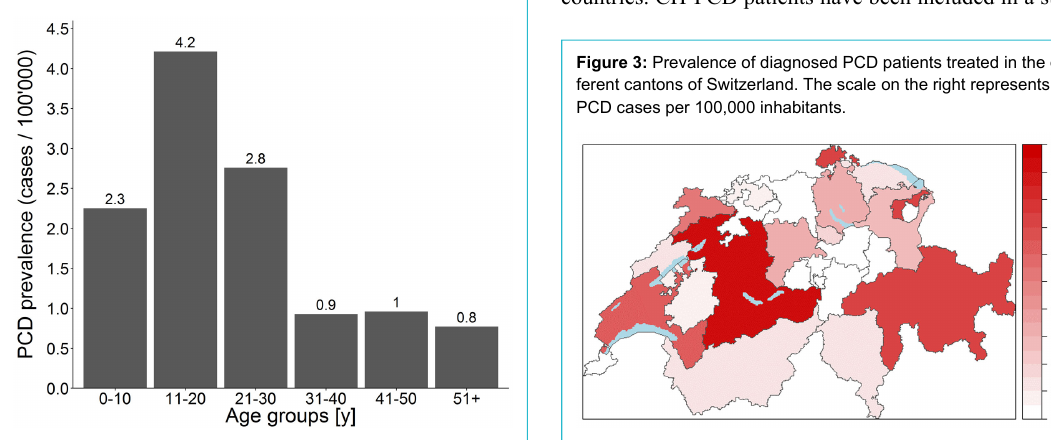
Figure 2: Prevalence of PCD diagnosed in Switzerland by age group, calculated by dividing the number of patients identified in the Swiss PCD registry by the number of the people in the respec- tive age group living in Switzerland. Prevalence is presented as